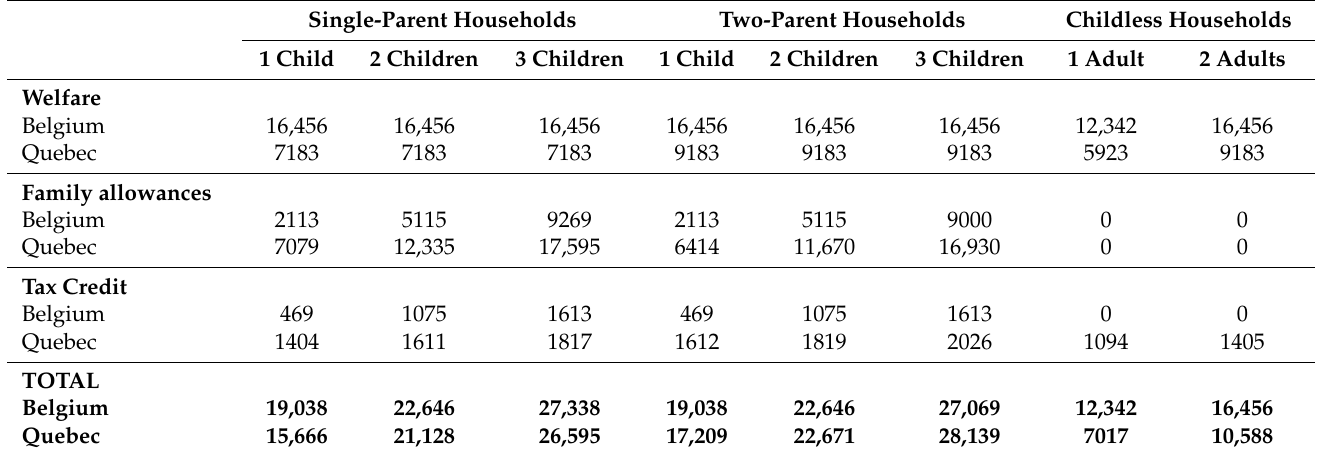
Table 1. Welfare and family allowance benefits (PPP 2015) in Belgium vs. Quebec. Single-Parent Households Two-Parent Households Childless